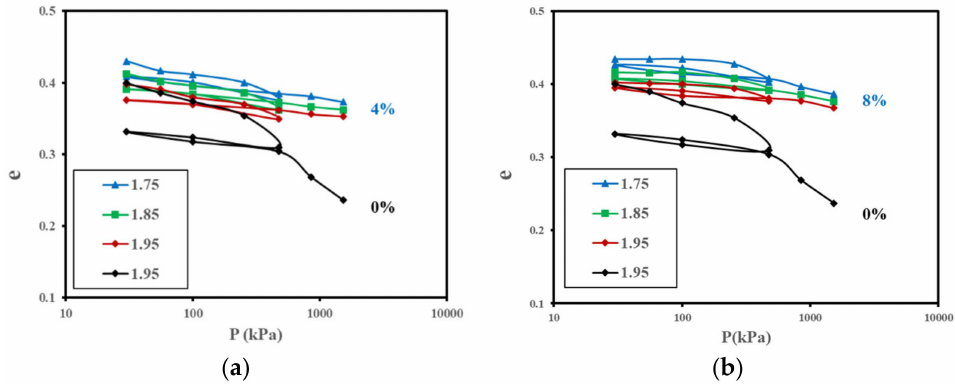
Figure 18. Compression curves of untreated and treated samples based on a soil consolidated test: ( a ) mudstone and mudstone–cement with C = 4%; ( b ) mudstone and untreated mudstone–cement with C = 8%.